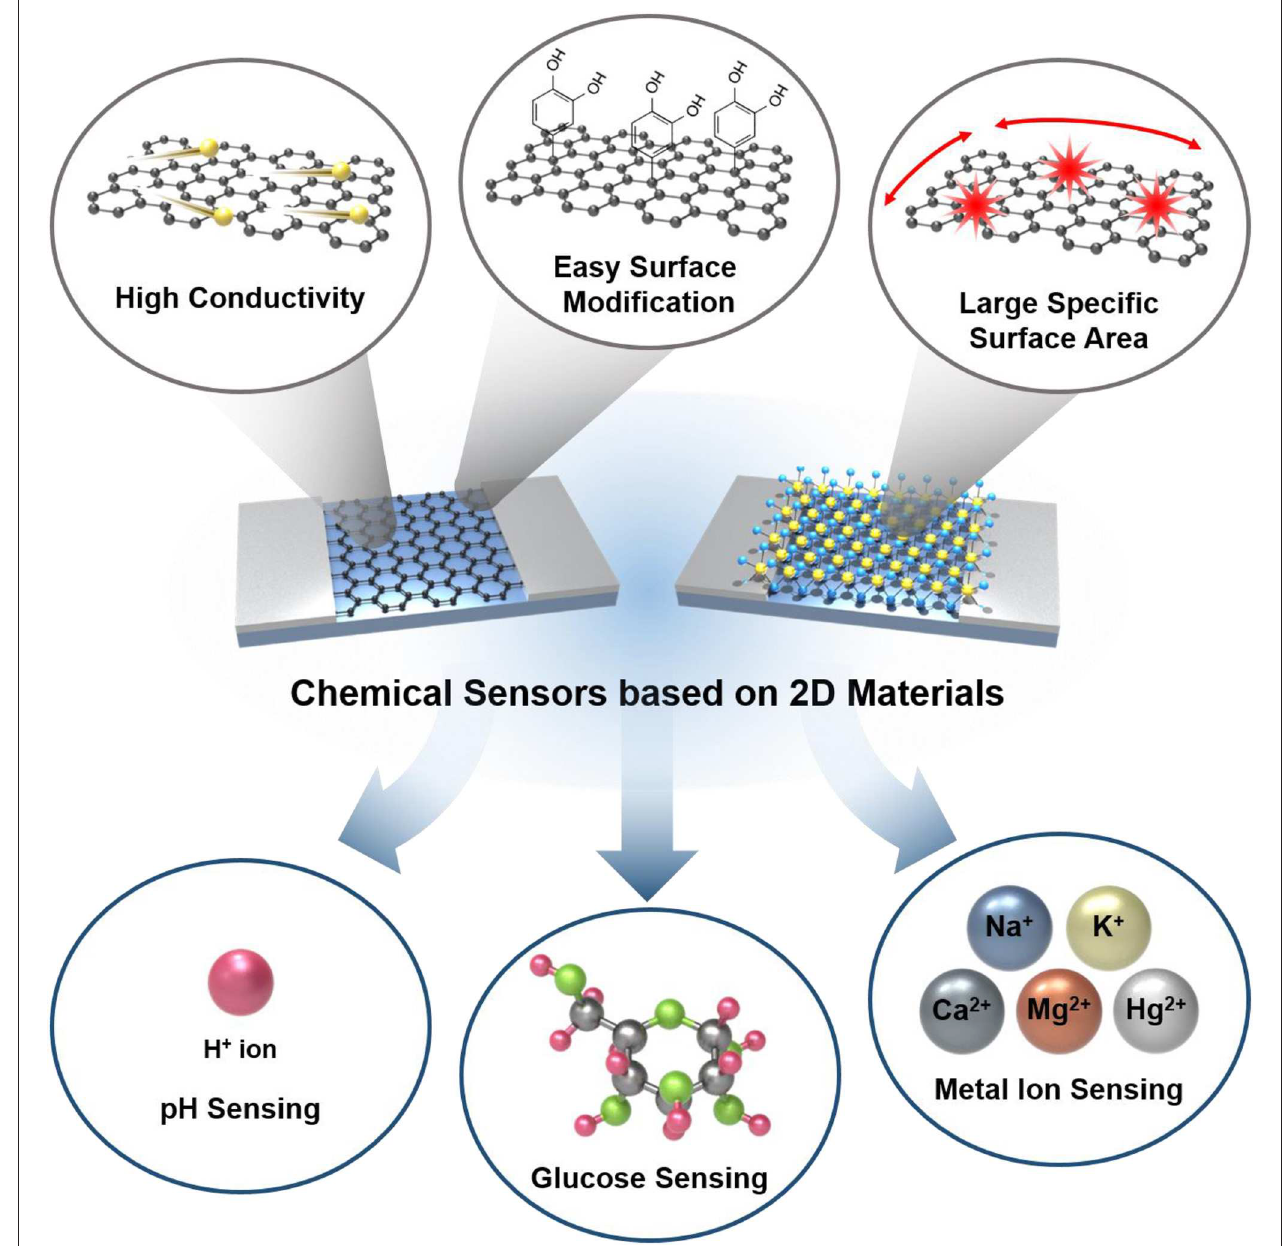
FIGURE 1 | Schematic illustration of chemical sensors based on 2D materials with advantages of 2D materials and their application into ion/molecule sensing.